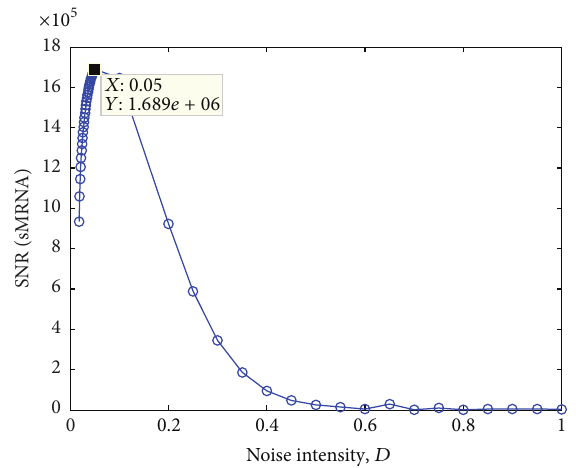
Figure 6: SNR as functions of the noise amplitude 𝐷